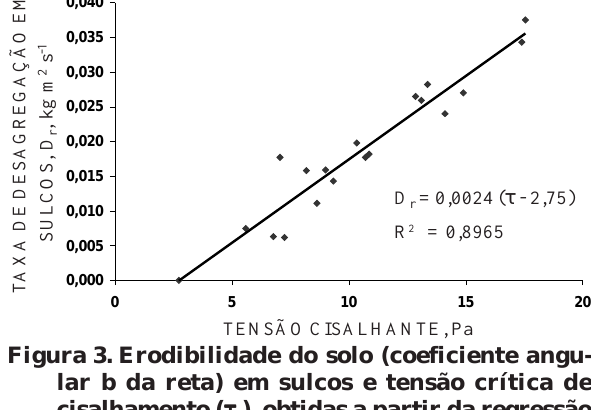
Figura 3. Erodibilidade do solo (coeficiente angu- lar b da reta) em sulcos e tensão crítica de cisalhamento ( ττ ττ τ ), obtidas a partir da regressão c das taxas de desagregação do solo (D ) com as r respectivas tensões de cisalhamento do escoa- mento ( τττττ ), observadas com a aplicação dos flu- xos extras no escoamento superficial gerado pela chuva simulada, em sulcos pré-formados em solo franco-argilo-arenoso